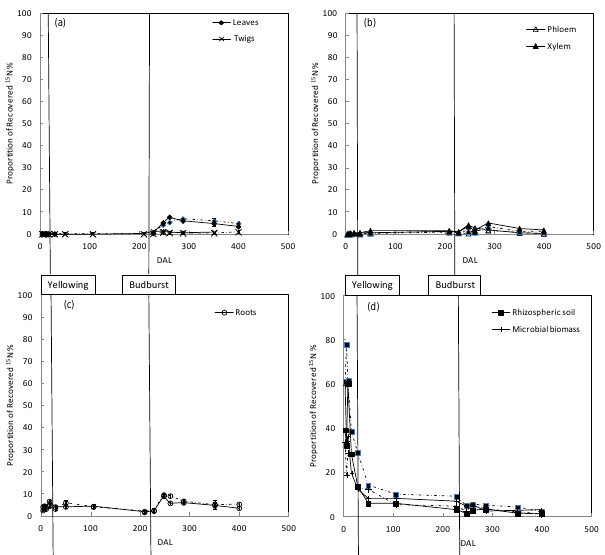
Figure 3. Partitioning of recovered 15 N (PRN%) from the sampled compartments following the third labelling campaign, i.e. from 8 April 2010 to 20 October 2010. a Leaves ♦ and twigs × , (b) phloem (cid:49) , (c) fine roots ○ , (d) rhizospheric soil and microbial biomass + . DAL: days after labelling. The two lines for each category (con- tinuous and dotted) correspond to tree 5 and tree 6. Vertical bars indicate standard